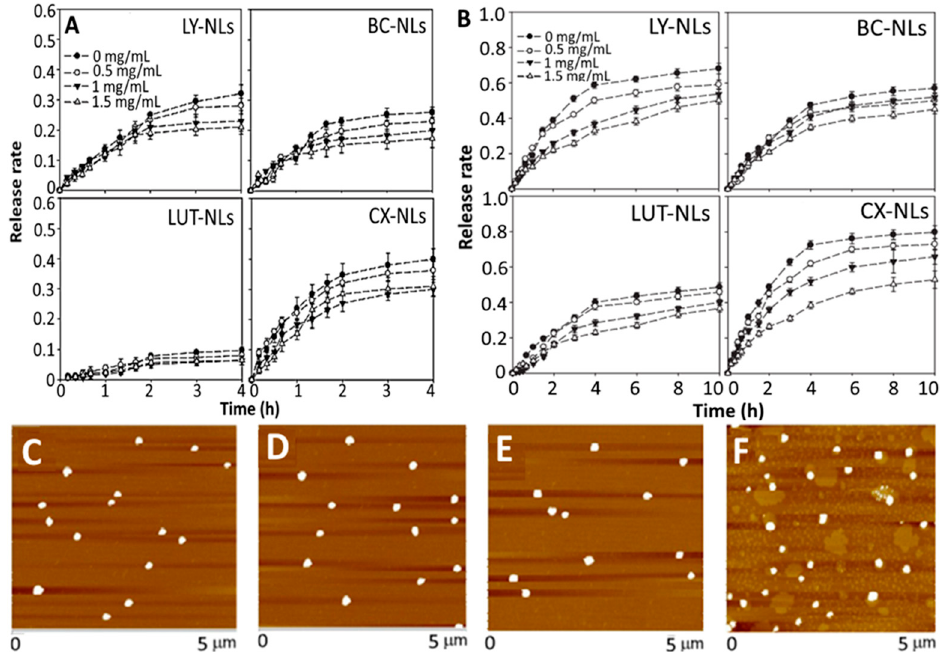
Figure 6. In vitro release of lycopene, β -carotene, lutein and canthaxanthin from respective carotenoid nanoliposomes and chitosan-coated carotenoid nanoliposomes (0.5–1.5 mg/mL chitosan) in simulated gastric fluid ( A ), intestinal fluid ( B ) along with the atomic force microscopic images of lycopene nanoliposomes ( C ), β -carotene nanoliposomes ( D ), lutein nanoliposomes ( E ) and canthaxanthin nanoliposomes ( F ). The results were expressed as mean ± standard deviation of ≥ 3 independent replicates and error bars represent the standard deviation from mean values. NLs = nanoliposomes, LY = lycopene, BC = β -carotene, LUT = lutein and CX = canthaxanthin. Adapted with permission from Tan, et al. [51] and Xia, et al. [88].